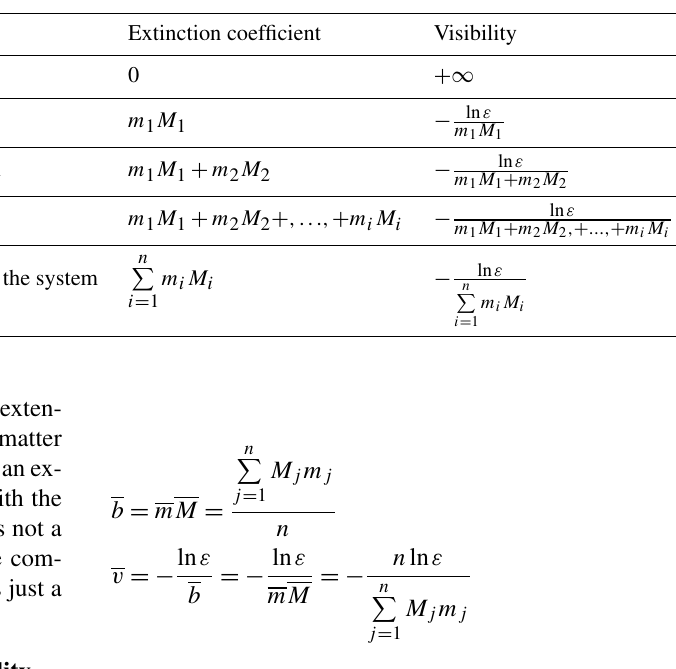
Method 2. Substitute the observed mass